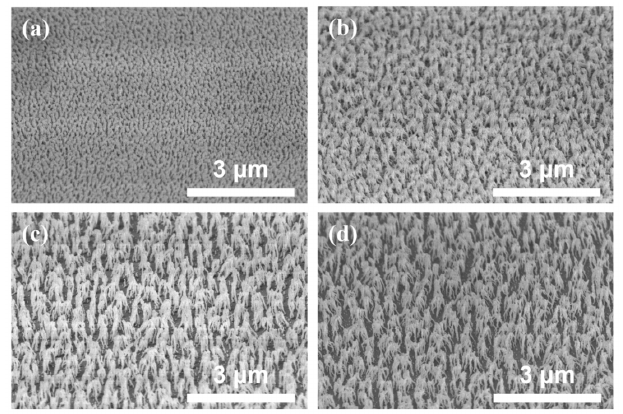
Figure 2. Cross-sectional scanning electron microscopy images (tilt angle of 45 ◦ ) of random nanos- tructures (RNSs) obtained under different plasma-etching conditions: ( a ) RNSs 1-1, ( b ) RNSs 1-2, ( c ) RNSs 1-3, and ( d ) RNSs 1-4.